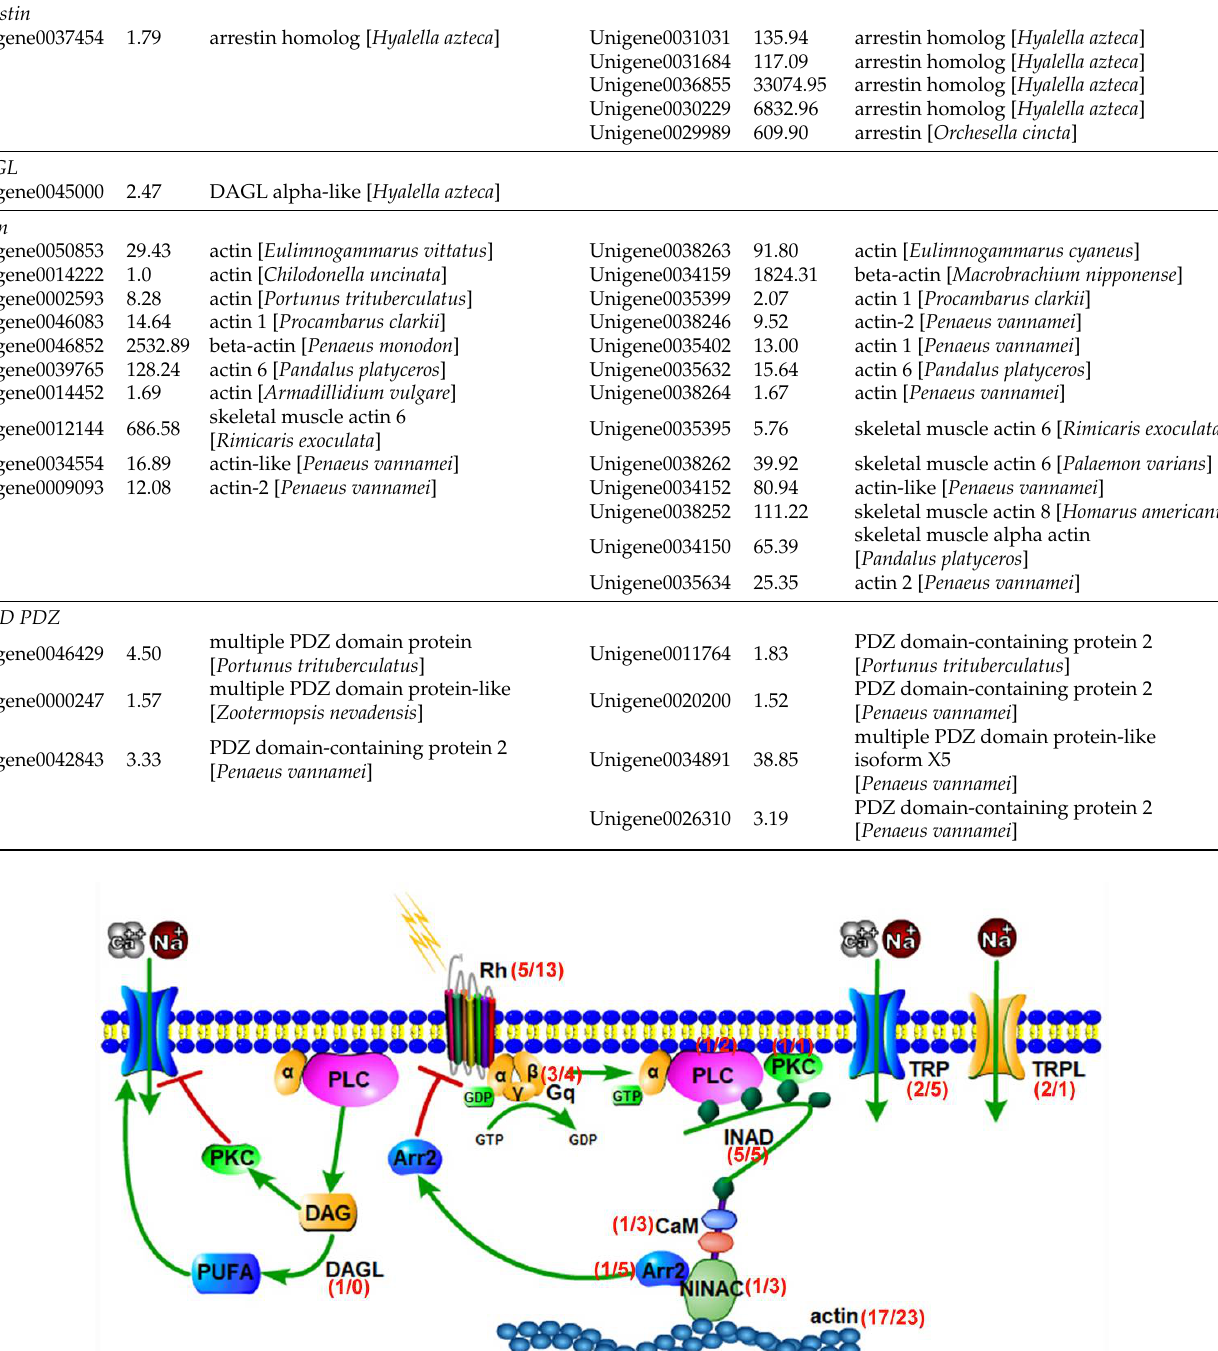
Figure 4. Opsin-mediated phototransduction pathway. The number of corresponding genes is listed in the red bracket ( Alvinocaris longirostris / Palaemon carinicauda ). Table 2. Genes involved in the Gq-mediated phototransduction cascade from Alvinocaris longirostris and Palaemon carinicauda . They include opsin, G-protein, G-protein subunit alpha (Gα), beta (Gβ) and gamma (Gγ), Gq subclass of the G-protein alpha (Gαq) subunits, phospholipase C (PLC), pro- tein kinase C (PKC), transient receptor potential (TRP) channels, transient receptor potential-like (TRPL) channels, calmodulin (CaM), neither inactivation nor afterpotential protein C (NINAC), ar- restin, diacylglycerol lipase (DAGL), actin and INAD PDZ domains. RPKM (reads per kb per mil- lion reads) shows the gene expression level revealed by RNA-seq.